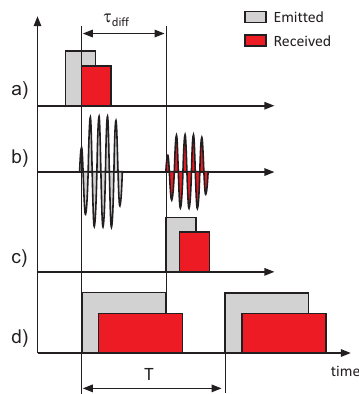
Figure 3. ( a ) Emitted and received optical signals from Base Station (BS) to Mobile Station (MS); ( b ) emitted and received ultrasound signals from BS to MS; ( c ) emitted and received optical pulse